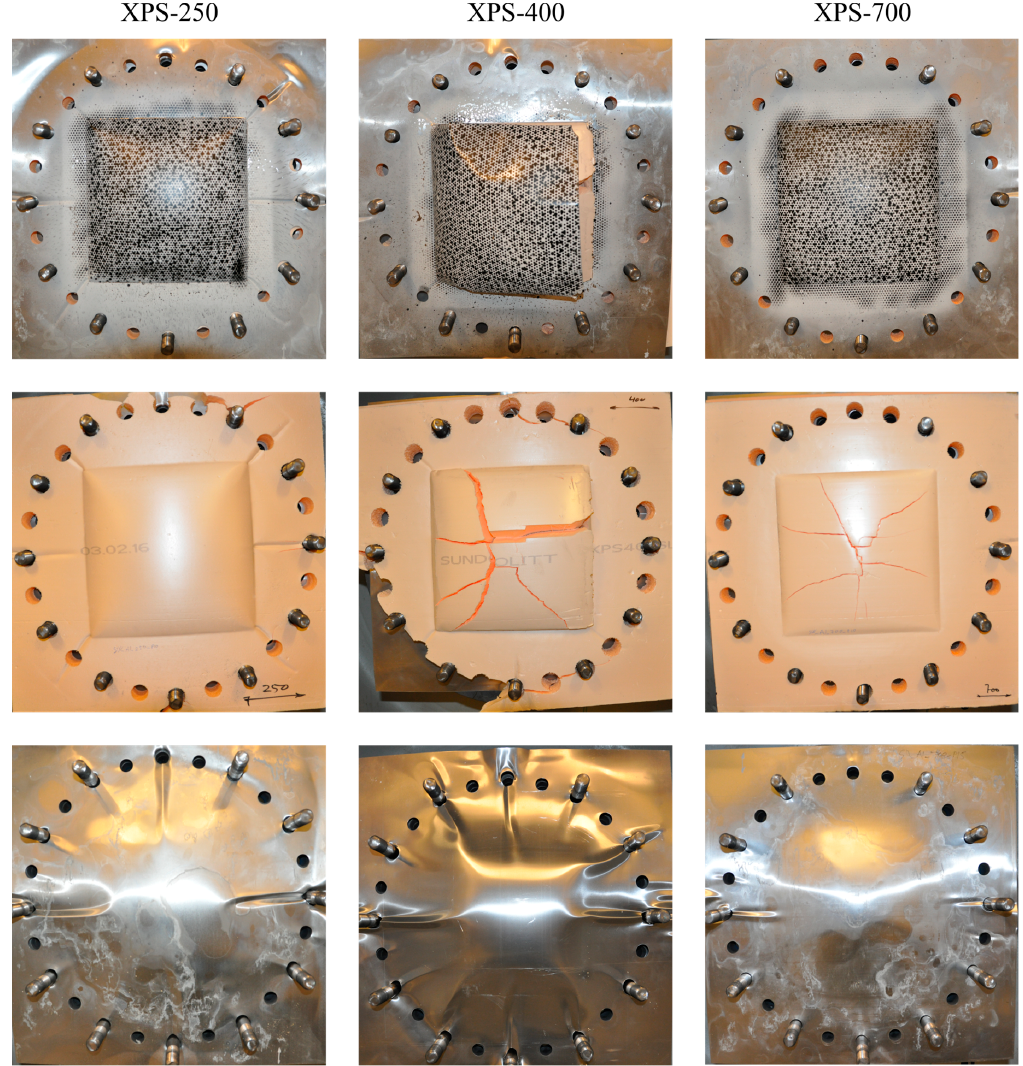
Figure 13. Post-test images of back skins (top), core (middle) and front skins (bottom) for series 1 at load level P15.